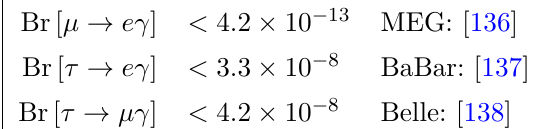
Table 6. Current experimental upper bounds on Br( ‘ → ‘ 0 γ ) .